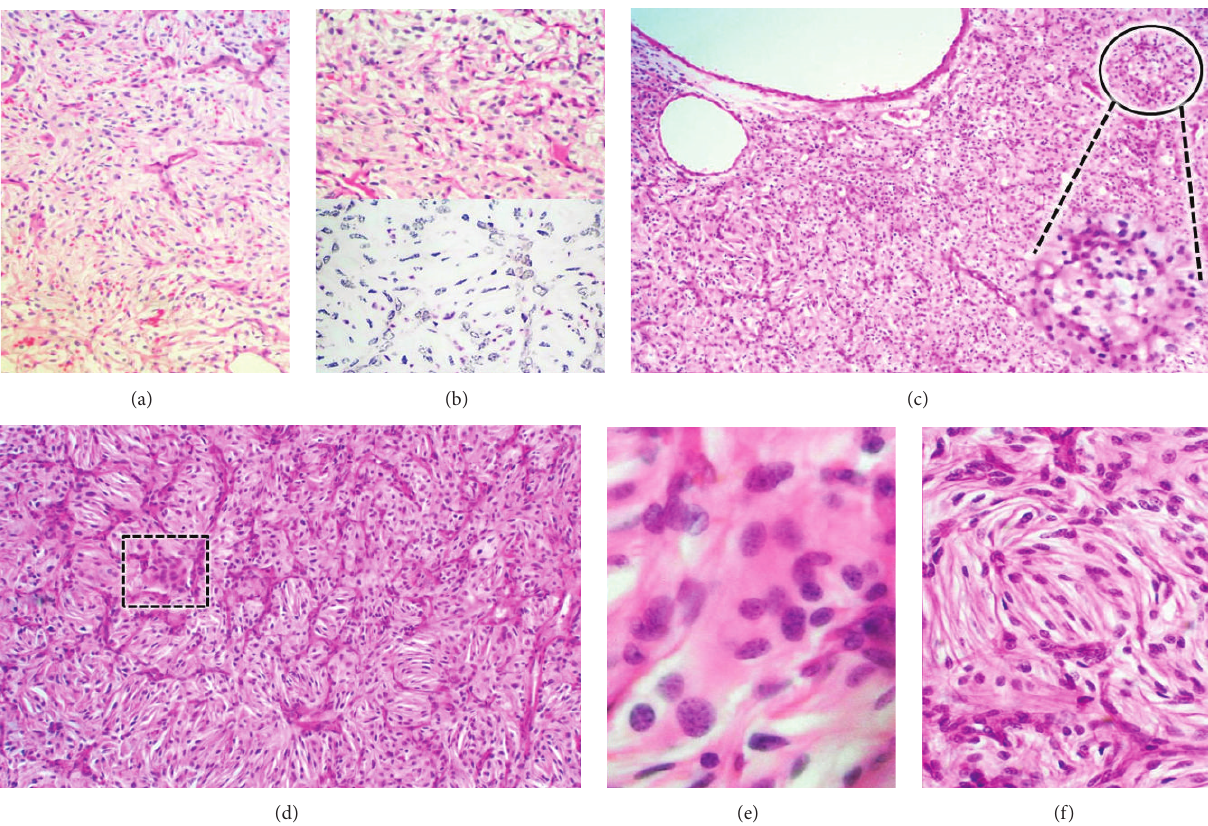
Figure 2: Light Microscopy Morphophenotype. (a) Spindle cells in the first resection sample. (b) Second resection sample: spindle cell component seen with haematoxylin and eosin (upper field) and with reticular fibers stain (lower field). The reticulin pattern is absent in the latter. (c) Third resection sample: transition area between fusiform stromal cells (left field) and conventional stromal cells (right field and lower inset). (d) Panoramic view of spindle cells in the third resection sample. A multinucleated giant cell can also be recognised (dotted- lined square). (e) High magnification photomicrograph of a syncytium-like cell. (f) Glomeruloid or yarn ball cluster of short-spindled cells “ gomitoli.